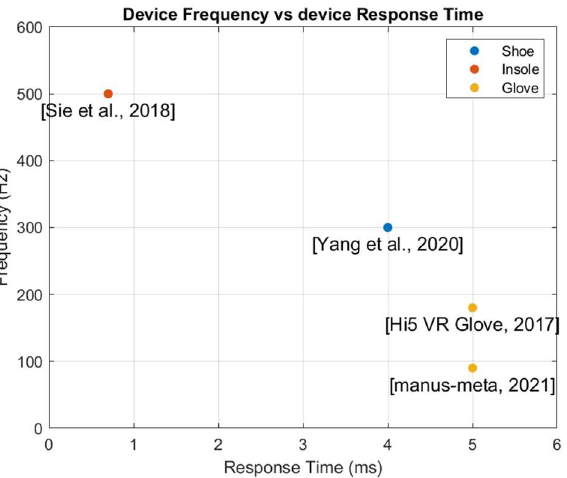
Figure 5. A sca(cid:308)er plot showing the response time of the haptic system against the motor voltage [55,62,64,70].